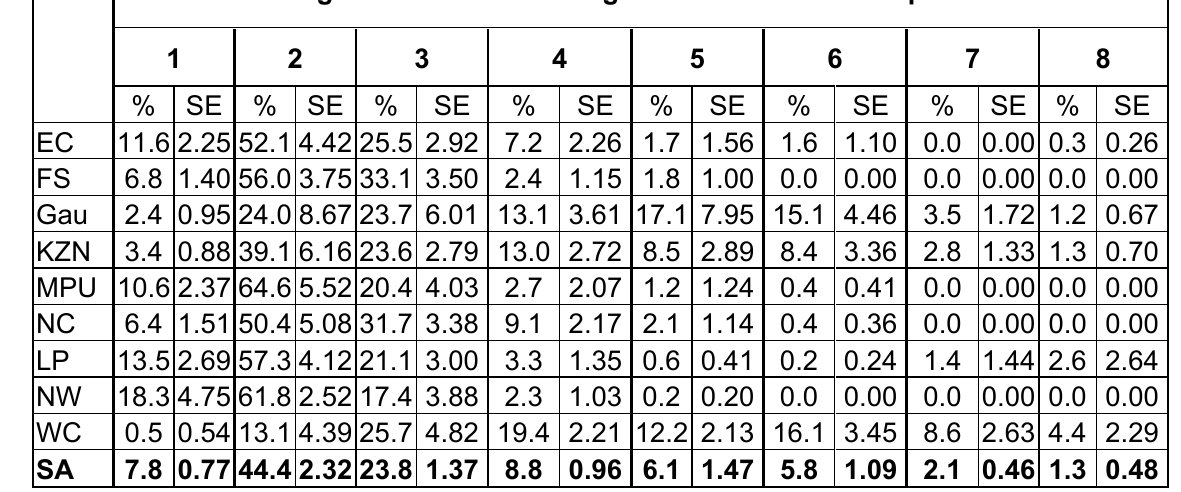
Table 2. Mathematics competence levels of learners